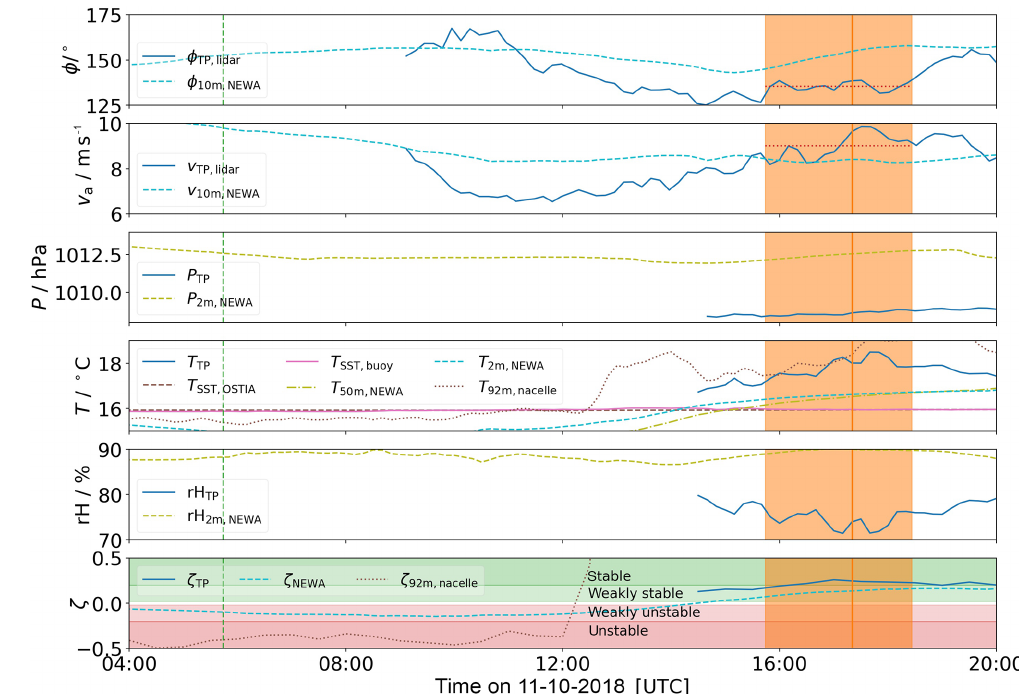
Figure 8. Meteorological data at the lidar location (turbine GT58) on 11 October 2018. Top to bottom: wind direction φ TP , lidar , wind speed v TP , lidar , air pressure P TP , air temperature T TP , sea surface temperatures T SST , OSTIA and T SST , buoy , relative humidity RH TP , and the dimensionless stability parameter ζ TP on the height of the TP of GT58 (24.6ma.m.s.l.). Since the measurements are not available during the whole day, we added the 10m wind speed v 10m , NEWA and direction φ 10m , NEWA , 2 and 50m temperature T 2m , NEWA and T 50m , NEWA and the stability parameter ζ NEWA from the NEWA data set (see Witha et al., 2019) as well as the temperature T 92m , nacelle and the derived stability parameter ζ 92m , nacelle on hub height of turbine GT58. Measurement times are marked as follows: vertical dashed line represents the SAR image (Fig. 9), vertical solid line represents the single lidar scan (Fig. 10), and shaded interval represents the averaged lidar wind field (Fig. 11). Mean wind speed and direction in the averaged lidar interval are marked by red horizontal dotted